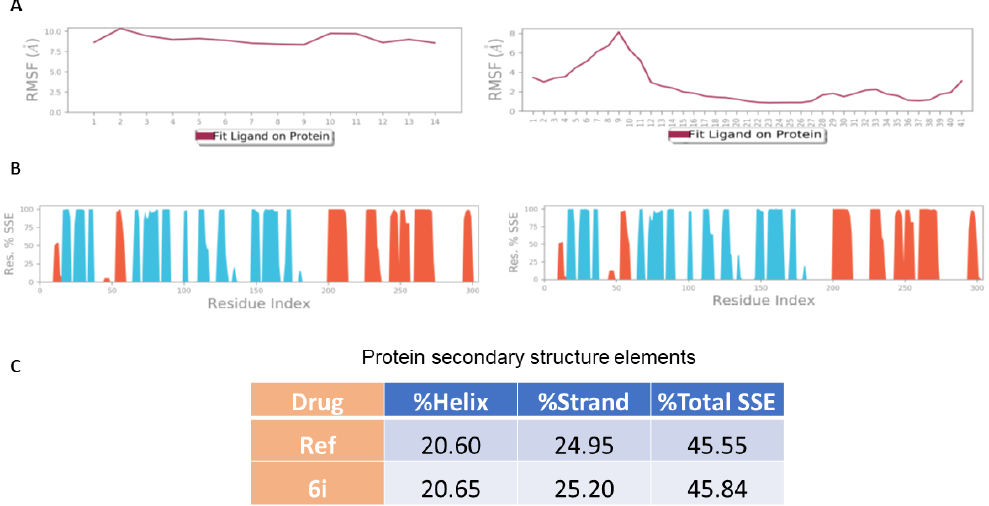
Figure 9. MD of Main protease (PDB ID: 5R80) data. ( A ) Secondary structure elements (SSE) of the complex Main protease (PDB ID: 5R80) with Z18197050 and 6i . No significance indicates that conformational stability appears from the absence of any change in the SSE percentage between both the apo and bound proteins. Ligand RMSF shows the ligand’s fluctuations broken down by atom, corresponding to the 2D structure in the top panel. The plot ( B ) reports SSE distribution by residue index throughout the protein structure. In plot ( C ), it shows the distribution of all elements of secondary structures appeared from MD runs of reference and 6i compounds.